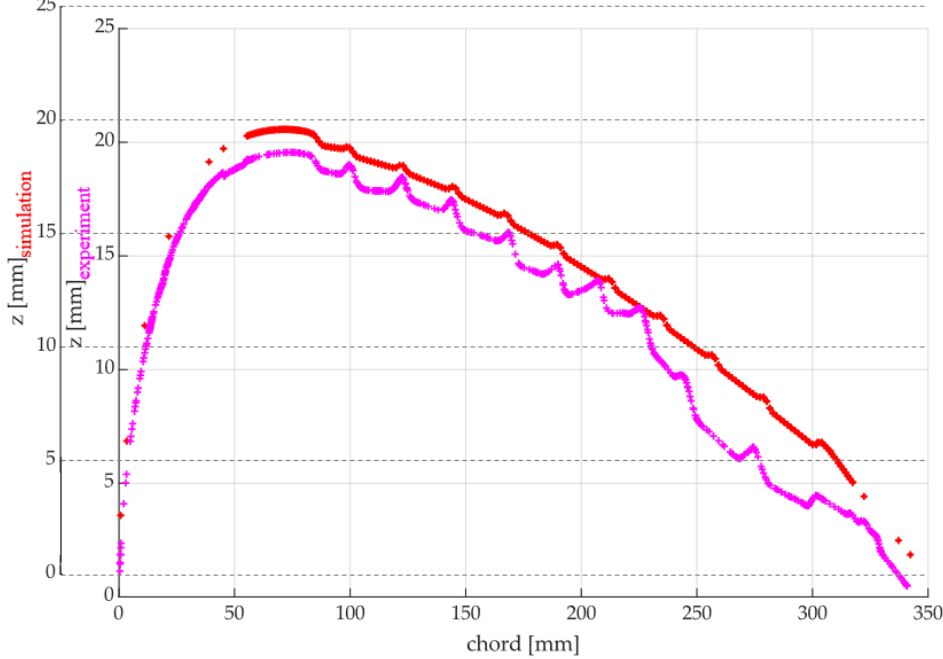
Figure 12. Comparison of the surfaces of Atos measurement (pink plus) and simulation (red pluses) in a sectional view with unequal axes. Values of the simulation have an offset of 1 mm for better clarity.